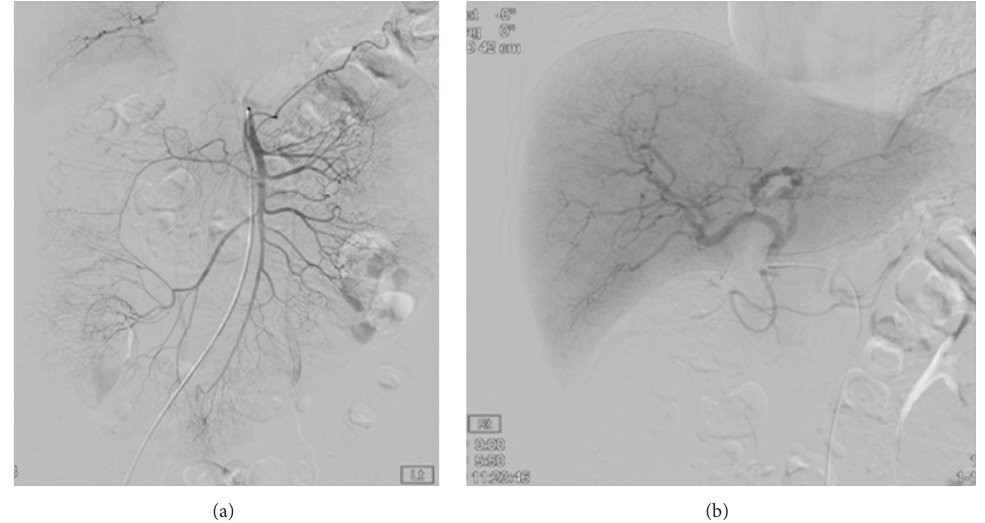
Figure 3: Conventional angiography showed to multiple dot-like small aneurysms, (a) at the jejunal branches of the superior mesenchymal artery and (b) branches of both hepatic